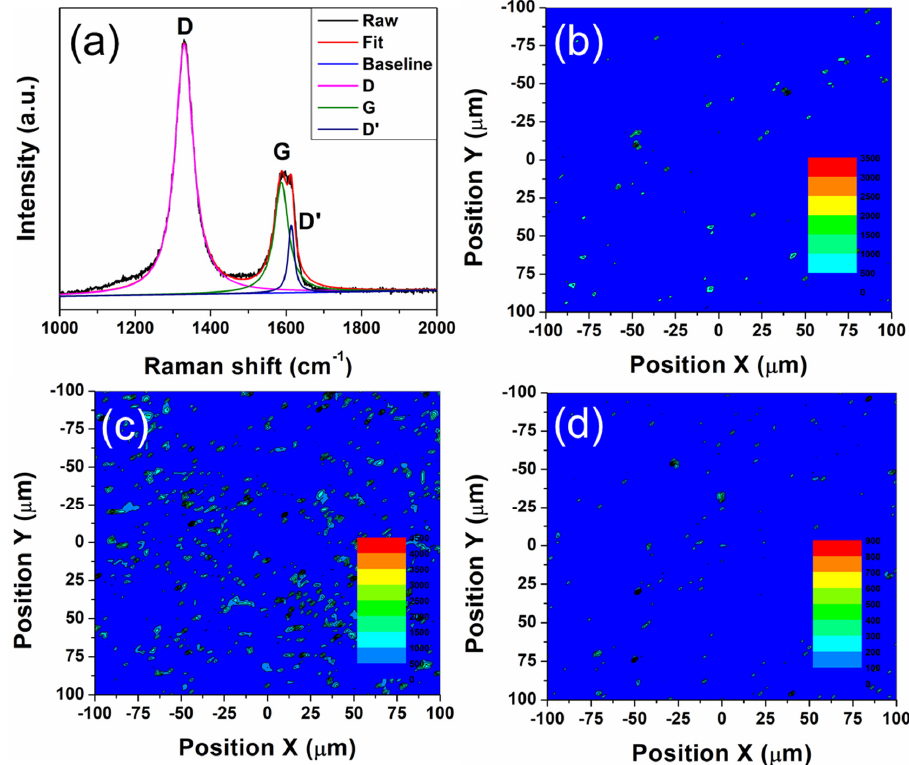
Figure 5. ( a ) Raman spectrum for a Cu-W composite with GO, including the raw spectrum and the curves for the fit spectrum, the baseline, D, G and D’ spectra. Raman mapping of the D band for Cu-W matrix composite with ( b ) 0.3 and ( c ) 0.5 wt.% GO sintered at 1000 °C. Raman mapping ( d ) for Cu-W matrix composite with 0.3 wt.% GO sintered at 1100 °C.